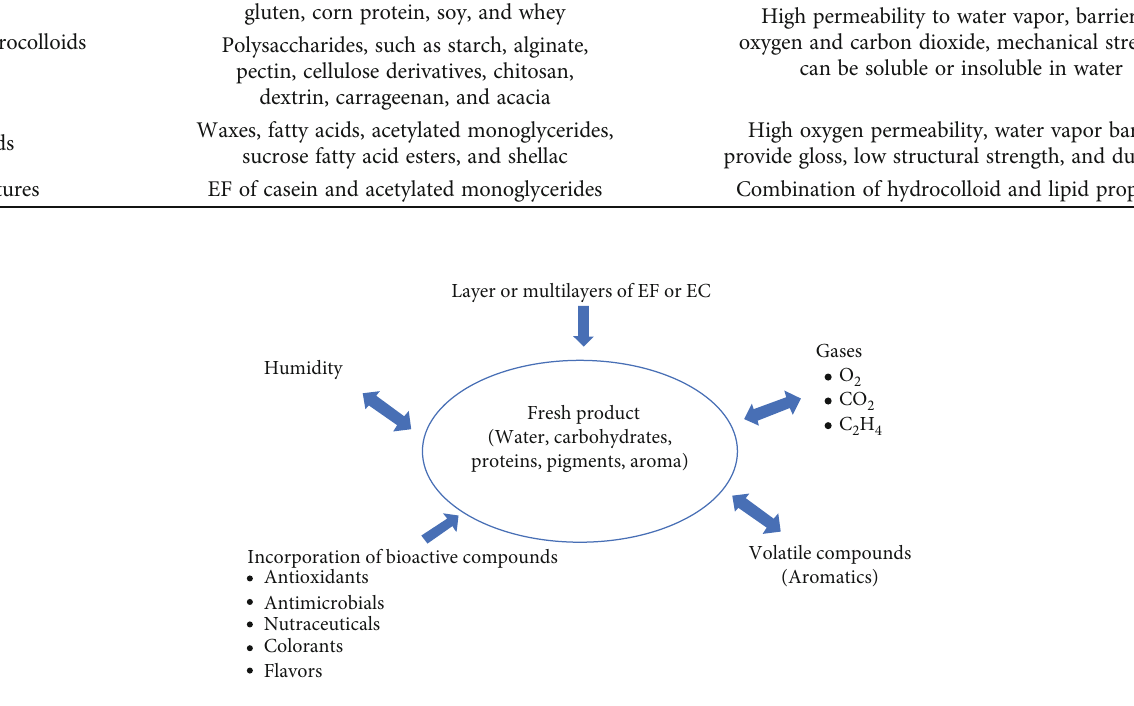
Figure 1: Barrier and transport e ff ect of an edible coating (EC) and/or an edible fi lm (EF) (adapted from Falguera et al.